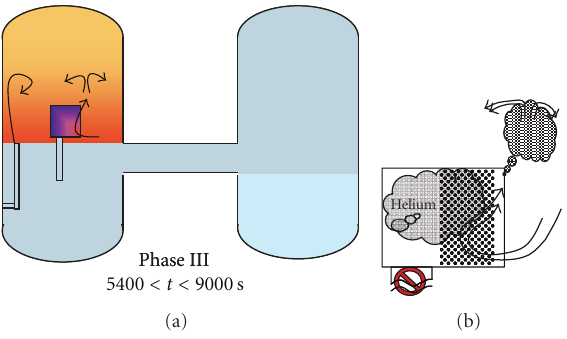
Figure 14: Suggested flow pattern for 3600 < t < 4800 s.